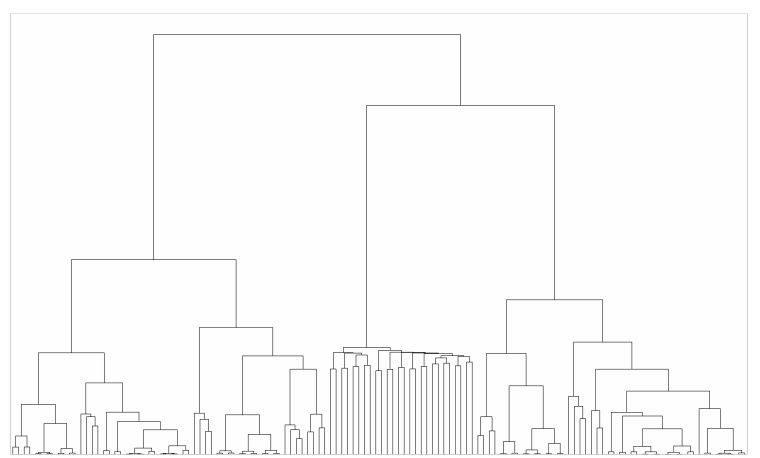
Figure 4. The result from Hierarchical Clustering (HC). From the top node to the bottom, features are divided by their correlations to the others. Further separated features are less similar to each other. Please note that the order of the features listed is based on the result of